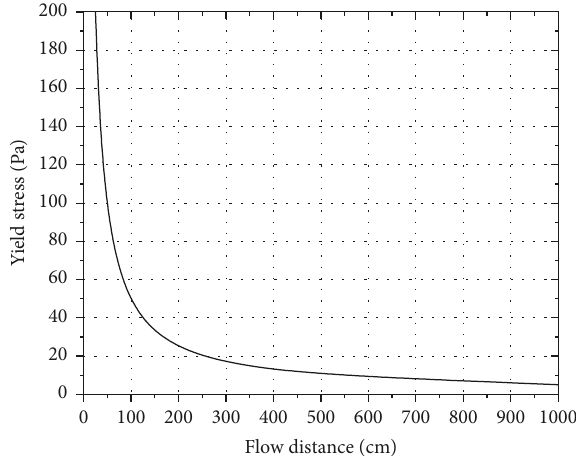
Figure 6: Relationship between flow distance and yield stress.